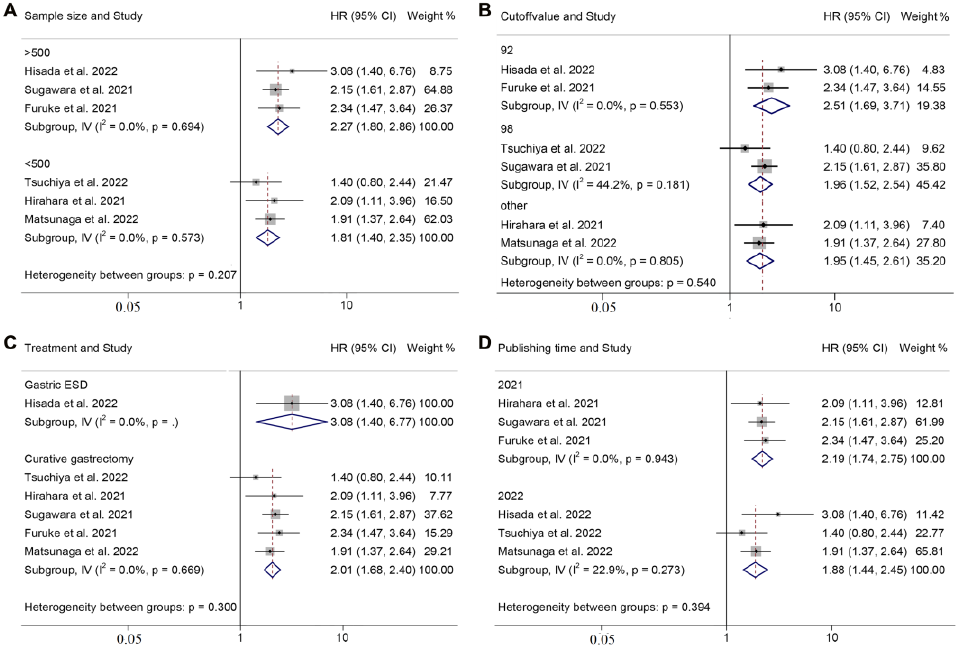
Figure 5. Subgroup analysis of postoperative complications based on sample size ( A ), cut-off value ( B ), treatment ( C ), and publishing year ( D ). ESD, endoscopic submucosal dissection; OR, odds ratio; CL, confidence interval [14,16 – 21]. 3.6. Publication Bias The publication bias was verified by Begg ’ s and Egger ’ s tests. We confirmed that there was no evidence of publication bias for OS (Egger’s test: p = 0.825; Begg ’s test: p = 0.707) or CSS (Egger’s test: p = 0.436; Begg’s test: p = 1.000) across the studies. Notably, the